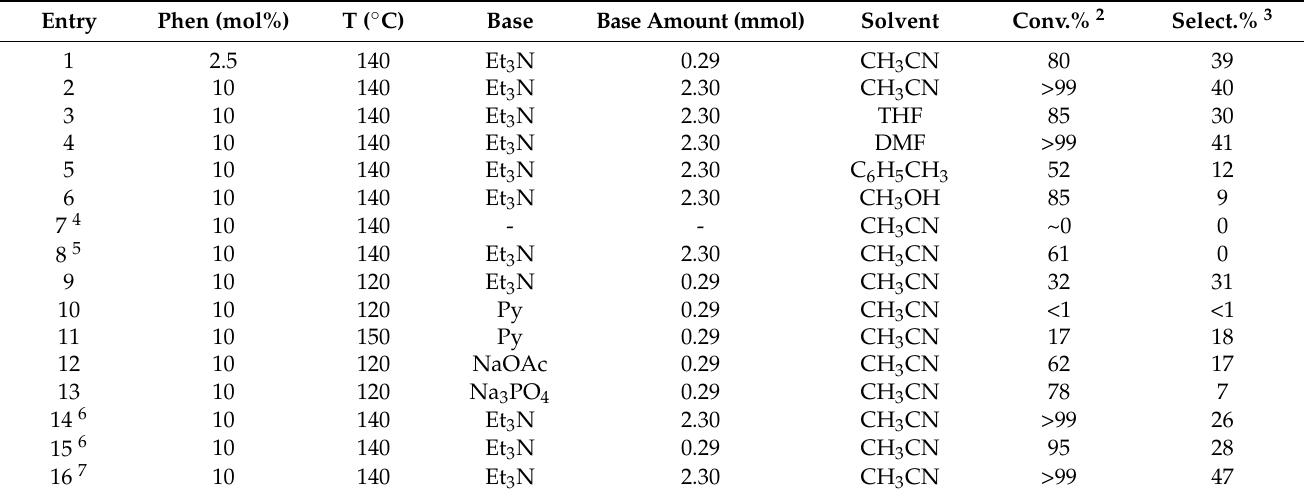
Table 1. Optimization of the reaction conditions for the reductive cyclization of β -methyl- β - nitrostyrene ( 1a ) to 2-methylindole ( 2a ) 1